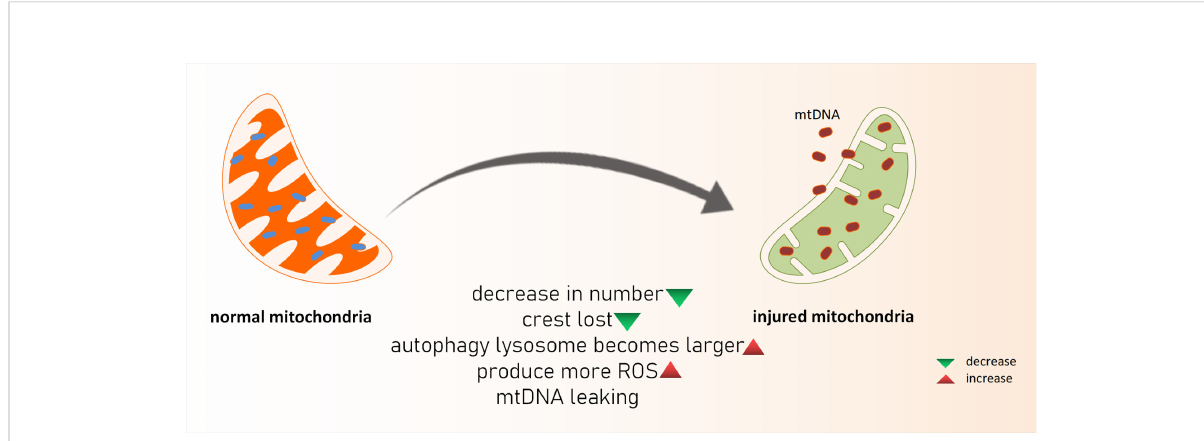
FIGURE 1 What happened to damaged mitochondria. mtDNA, mitochondria DNA; ROS, reactive oxygen